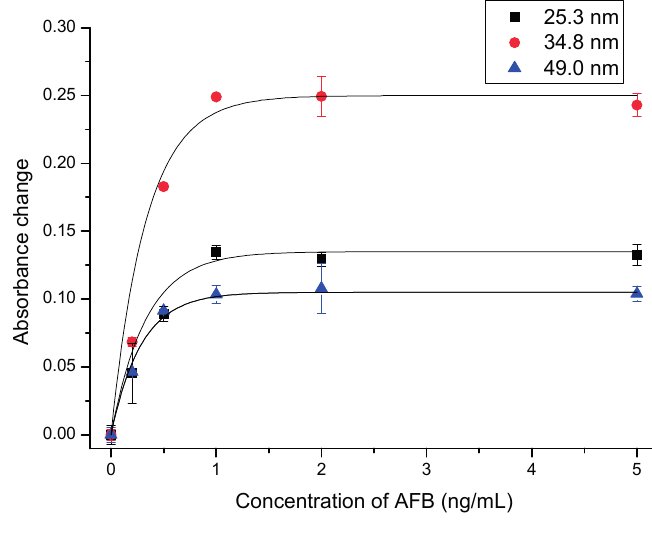
Figure 2. Dose-response curves for the detection of AFB using different size of